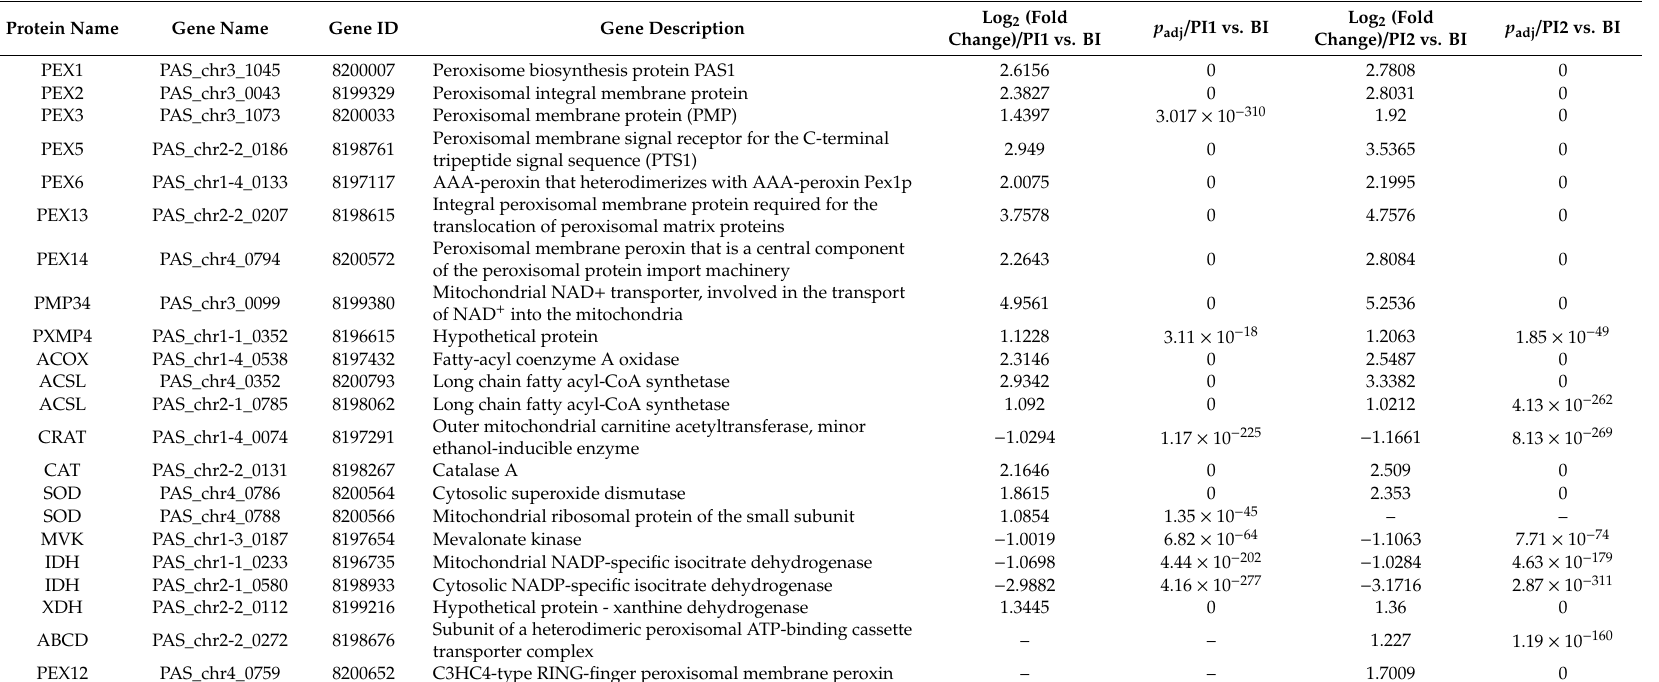
Table 3. List of DEGs encoding proteins of peroxisome in PI1 and PI2 in comparison to